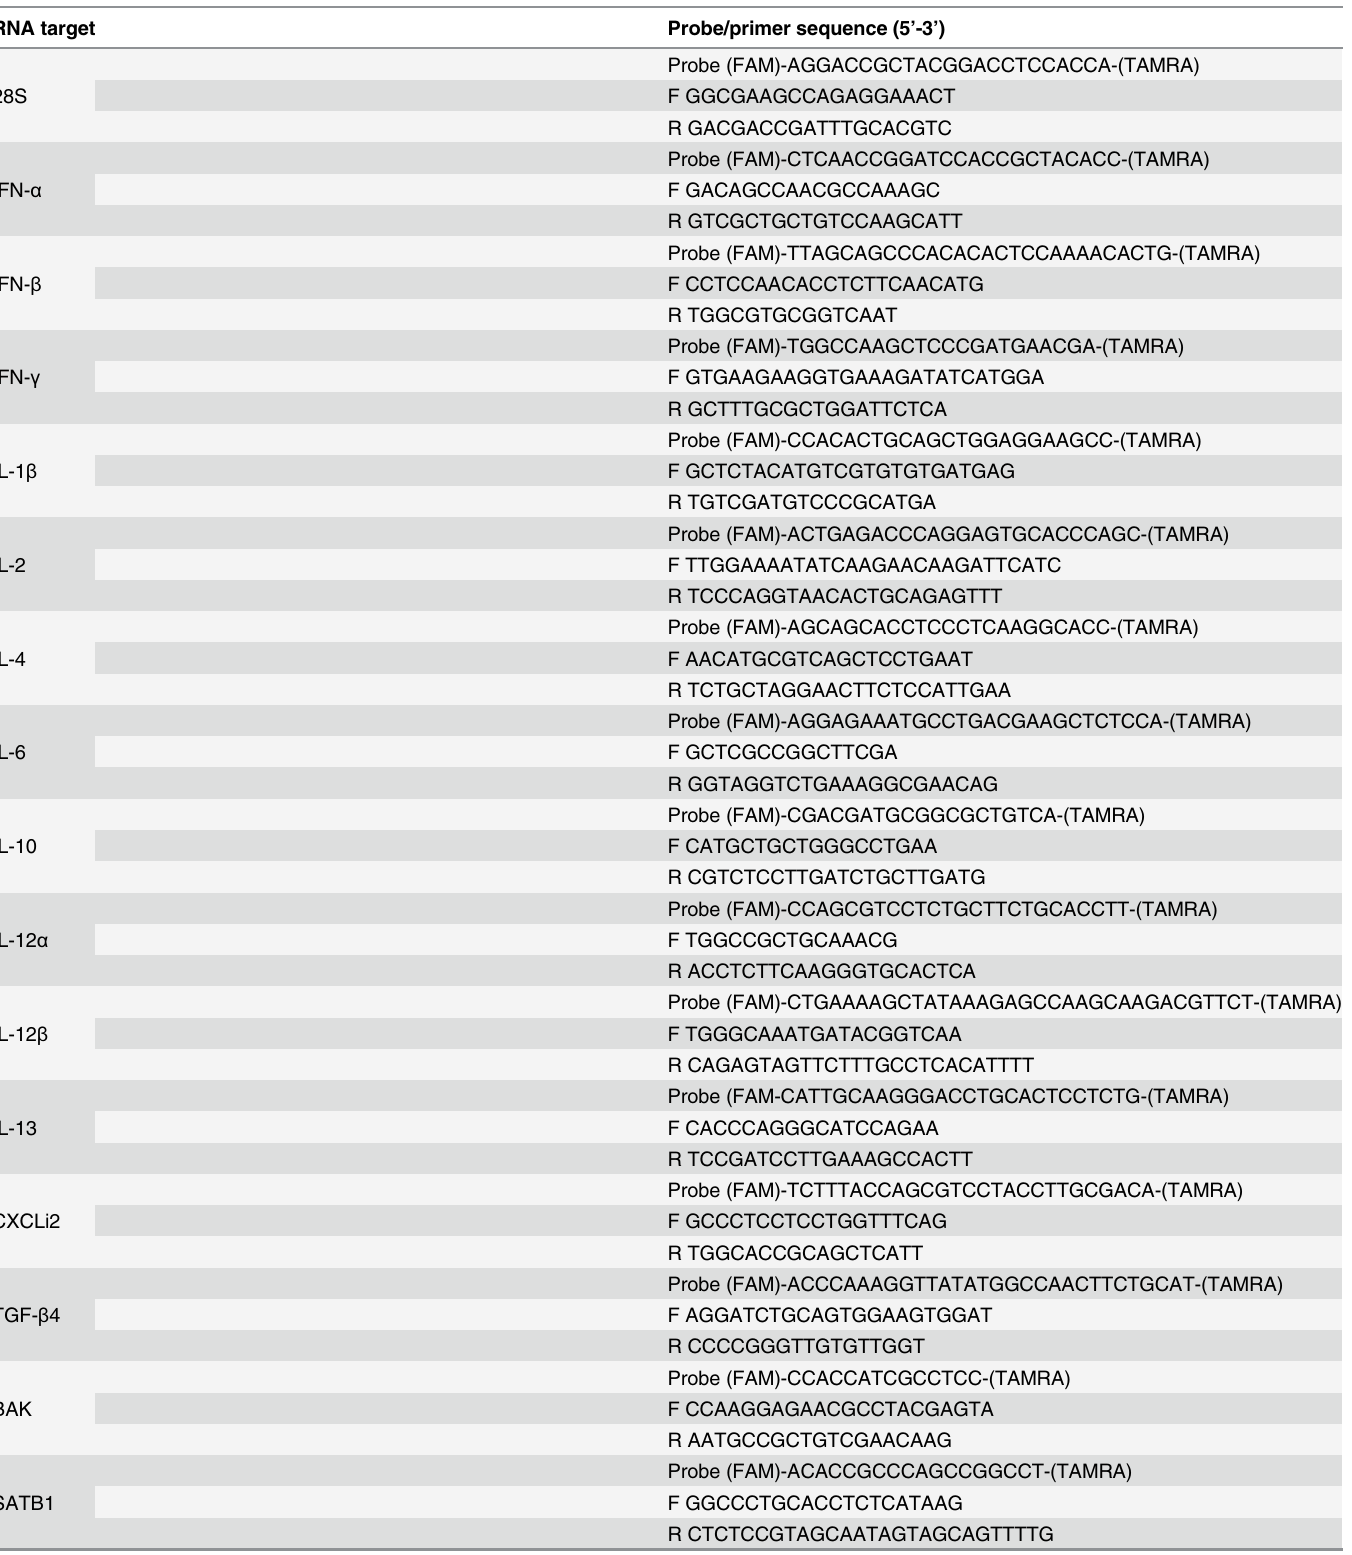
Table 2. Real-time quantitative RT-PCR probes and